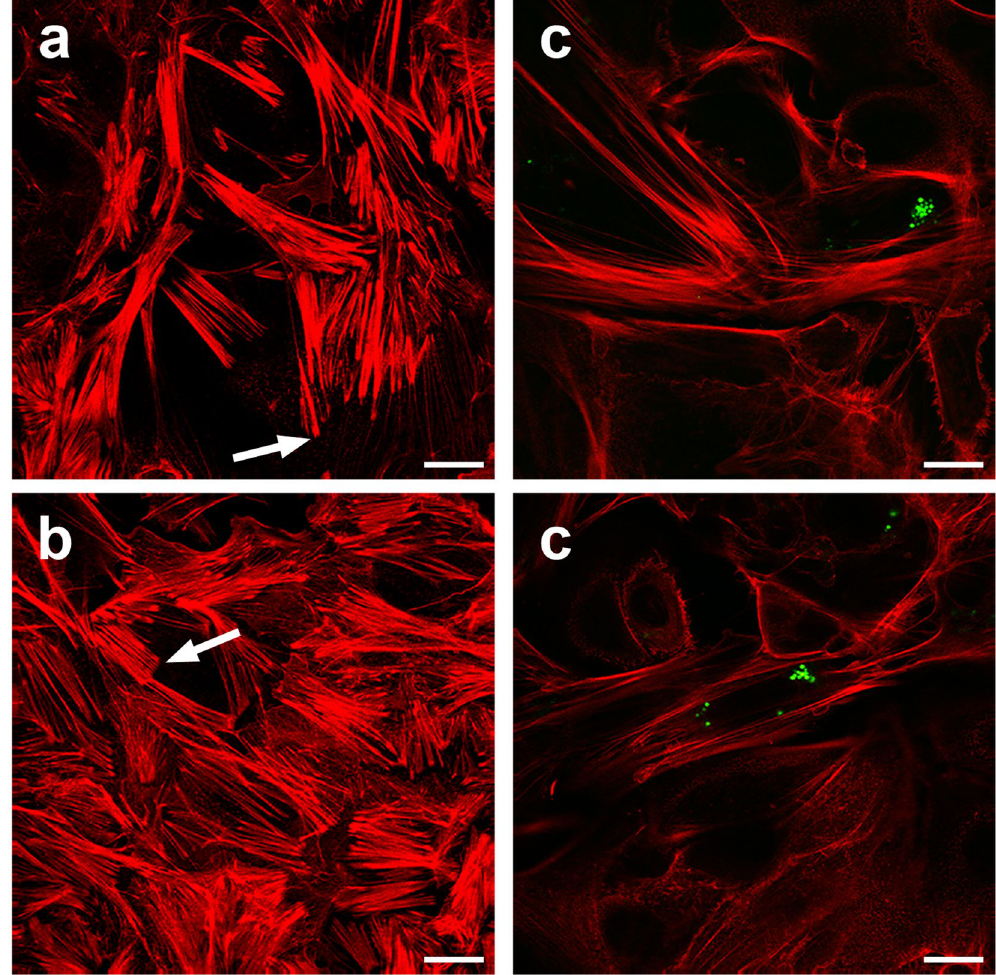
Figure 3. S . aureus invasion alters structure of the actin-cytoskeleton. Actin-fibers were stained with Alexa- Fluor tagged phalloidin from ( a ) control pbMEC cultures or ( b ) after 1 h co-culture with live E . coli 1303 or ( c ) GFP-tagged S . aureus 1027 pathogens. Images from control and E . coli co-cultured cells were dominated by short, thick ventral actin-stress fibers, mostly terminated by knob-forming focal adhesion foci. These were not evident in cells harboring the green fluorescent S . aureus pathogens. Instead, the actin fibers appeared more filamentous without apparent adhesion foci. (Scale bar, 10 µ